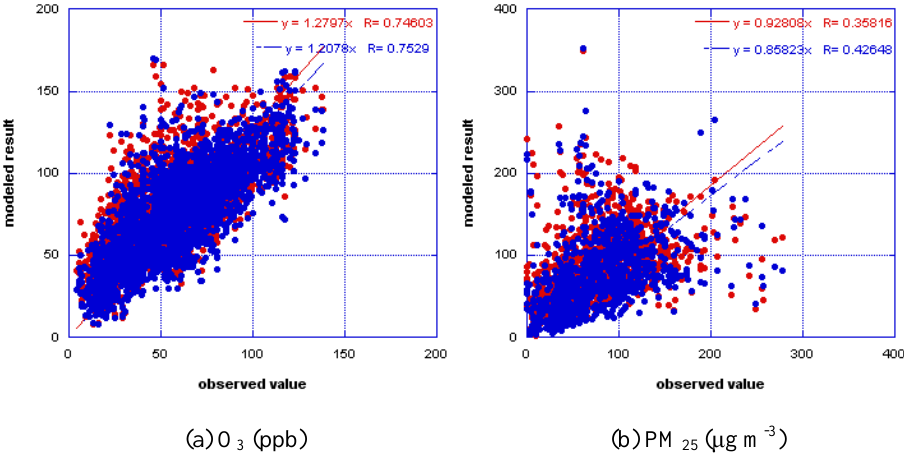
Figure 10. Daytime O 3 and PM25 model performance with AOD greater than or equal to 0.5 (same 3 Fig. 10. Daytime O 3 and PM 2 . 5 model performance with AOD greater than or equal to 0.5 (same colour code as in Fig. colour code as in Fig. 9) 4